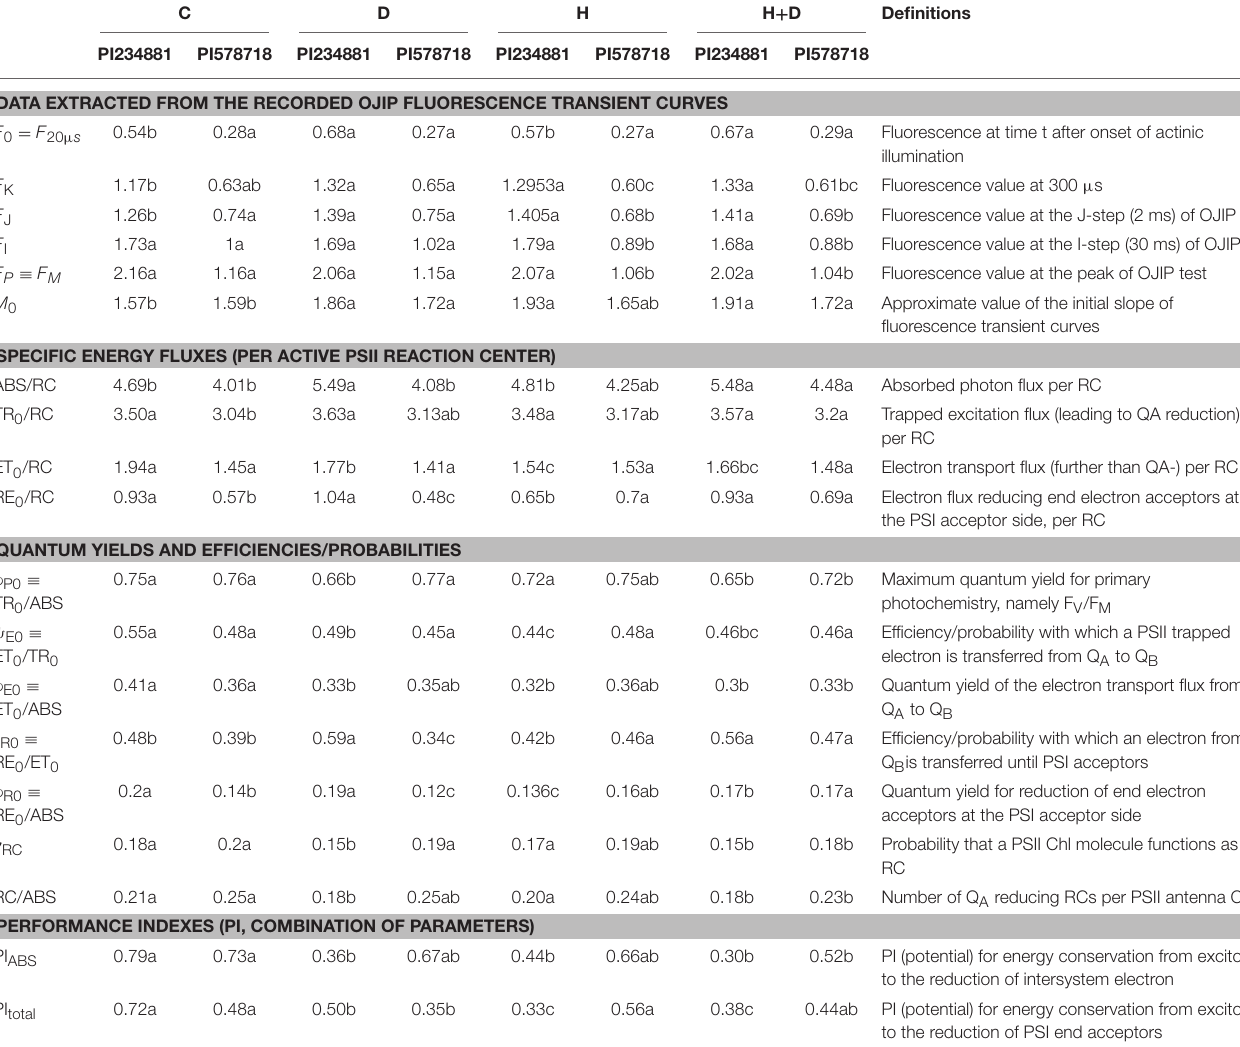
TABLE 1 | Photosynthetic parameters deduced by the JIP-test analysis of fluorescence transients. C D H H + D